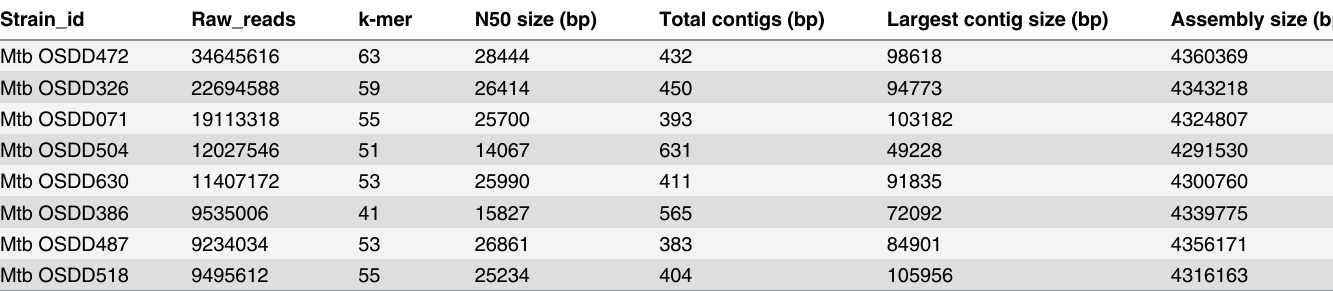
Gene prediction and clustering. Whole genome sequences (WGS) of the complete MTBC genomes and scaffold/contig assemblies of draft genomes were used to predict their coding sequences (CDS) / Open Reading Frames (ORFs). Standard bacteria/archaea translation codes were used for CDS prediction. An account of the number of CDS predicted along for each of the 96 strains is provided in Table 1. The predicted gene pool of the 96 strains was used to estimate the pangenome of Mtb. The gene repertoire of each of the 96 Mtb isolates Table 2. Genome Assembly Statistics of the eight Indian strains sequenced and assembled as part of the present